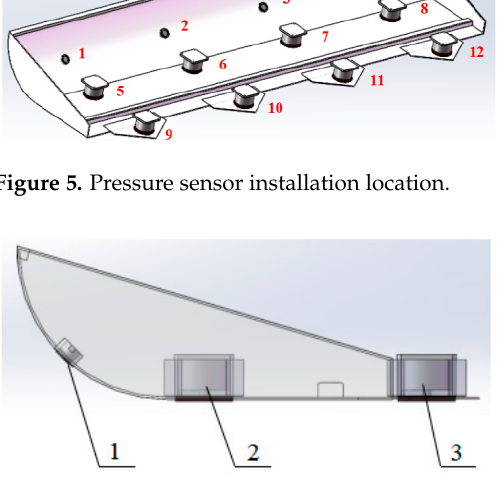
Figure 6. Pressure sensor installation location (Side view). 1. Forward resistance sensor. 2. Front pressure sensor. 3. Rear pressure sensor.